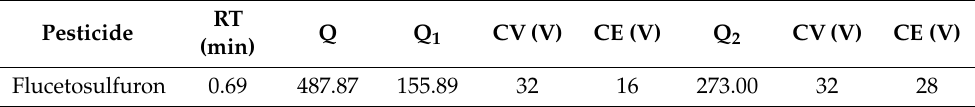
Table 2. Overview of the LC–MS/MS analysis of the flucetosulfuron. RT Q Q 1 CV (V) CE (V) Q 2 CV (V) CE (V) Pesticide (min) Flucetosulfuron 0.69 487.87 155.89 32 16 273.00 32